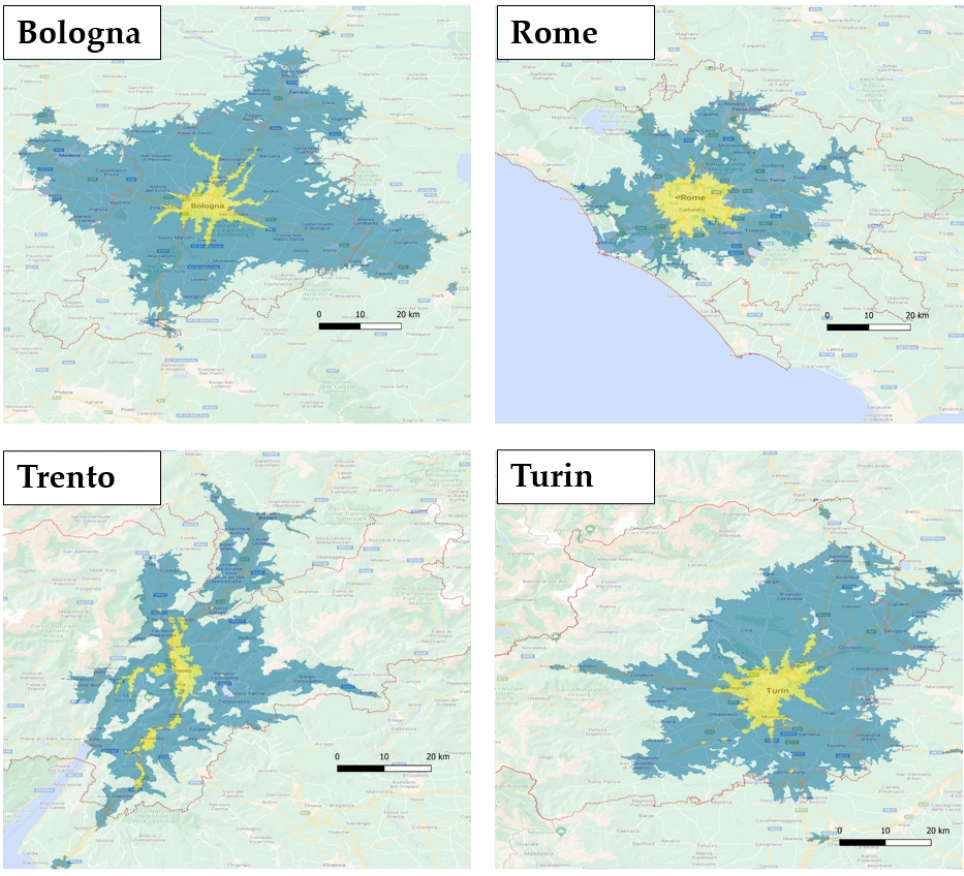
Figure 1. Isochrones of places that can be reached in 1 h by public transport/train (in yellow) and by car (in blue) in the four cities.